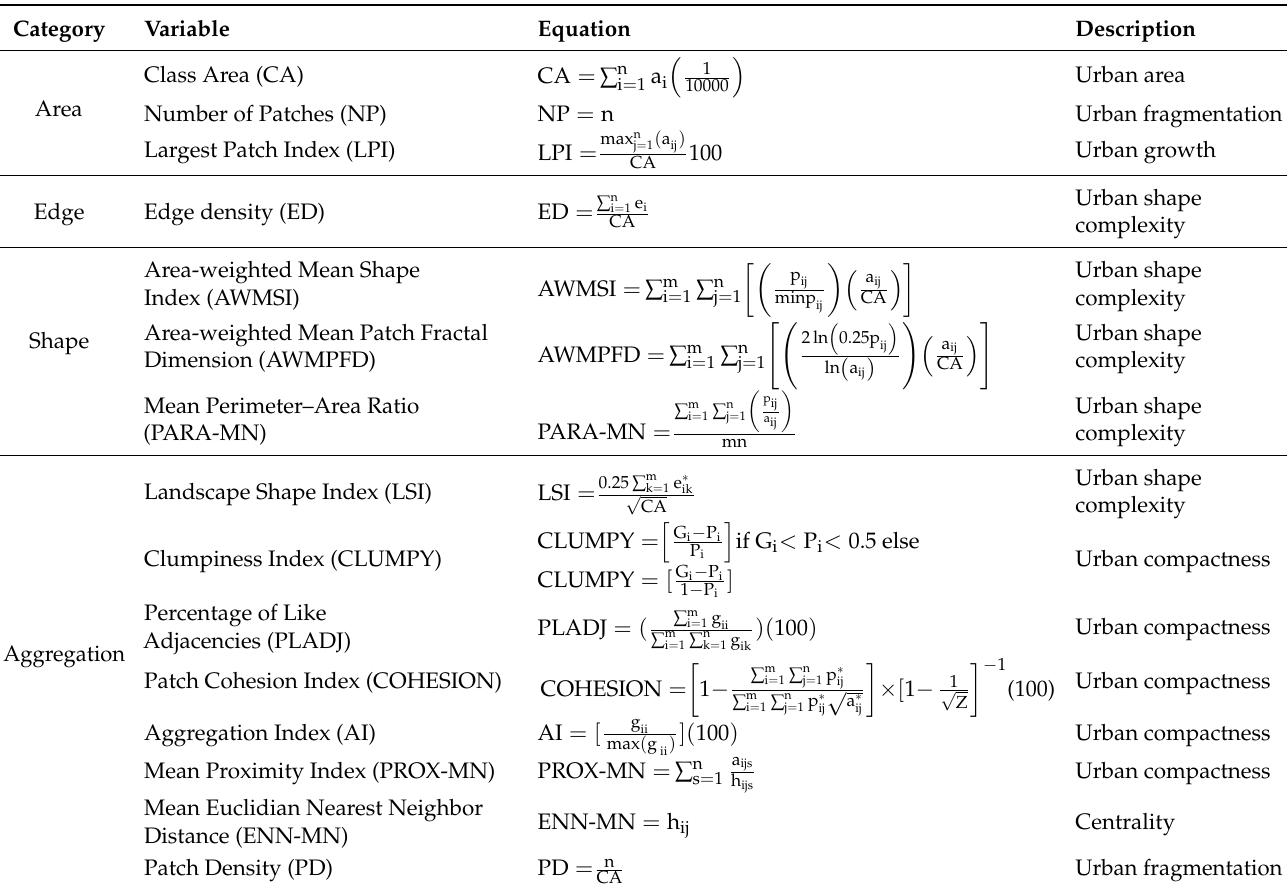
Table A1. Urban form landscape metric system.